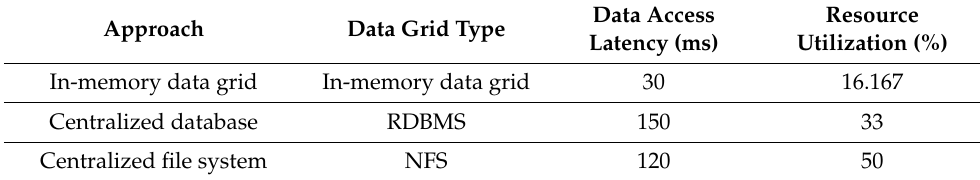
Table 10. Experimental results for scheduling